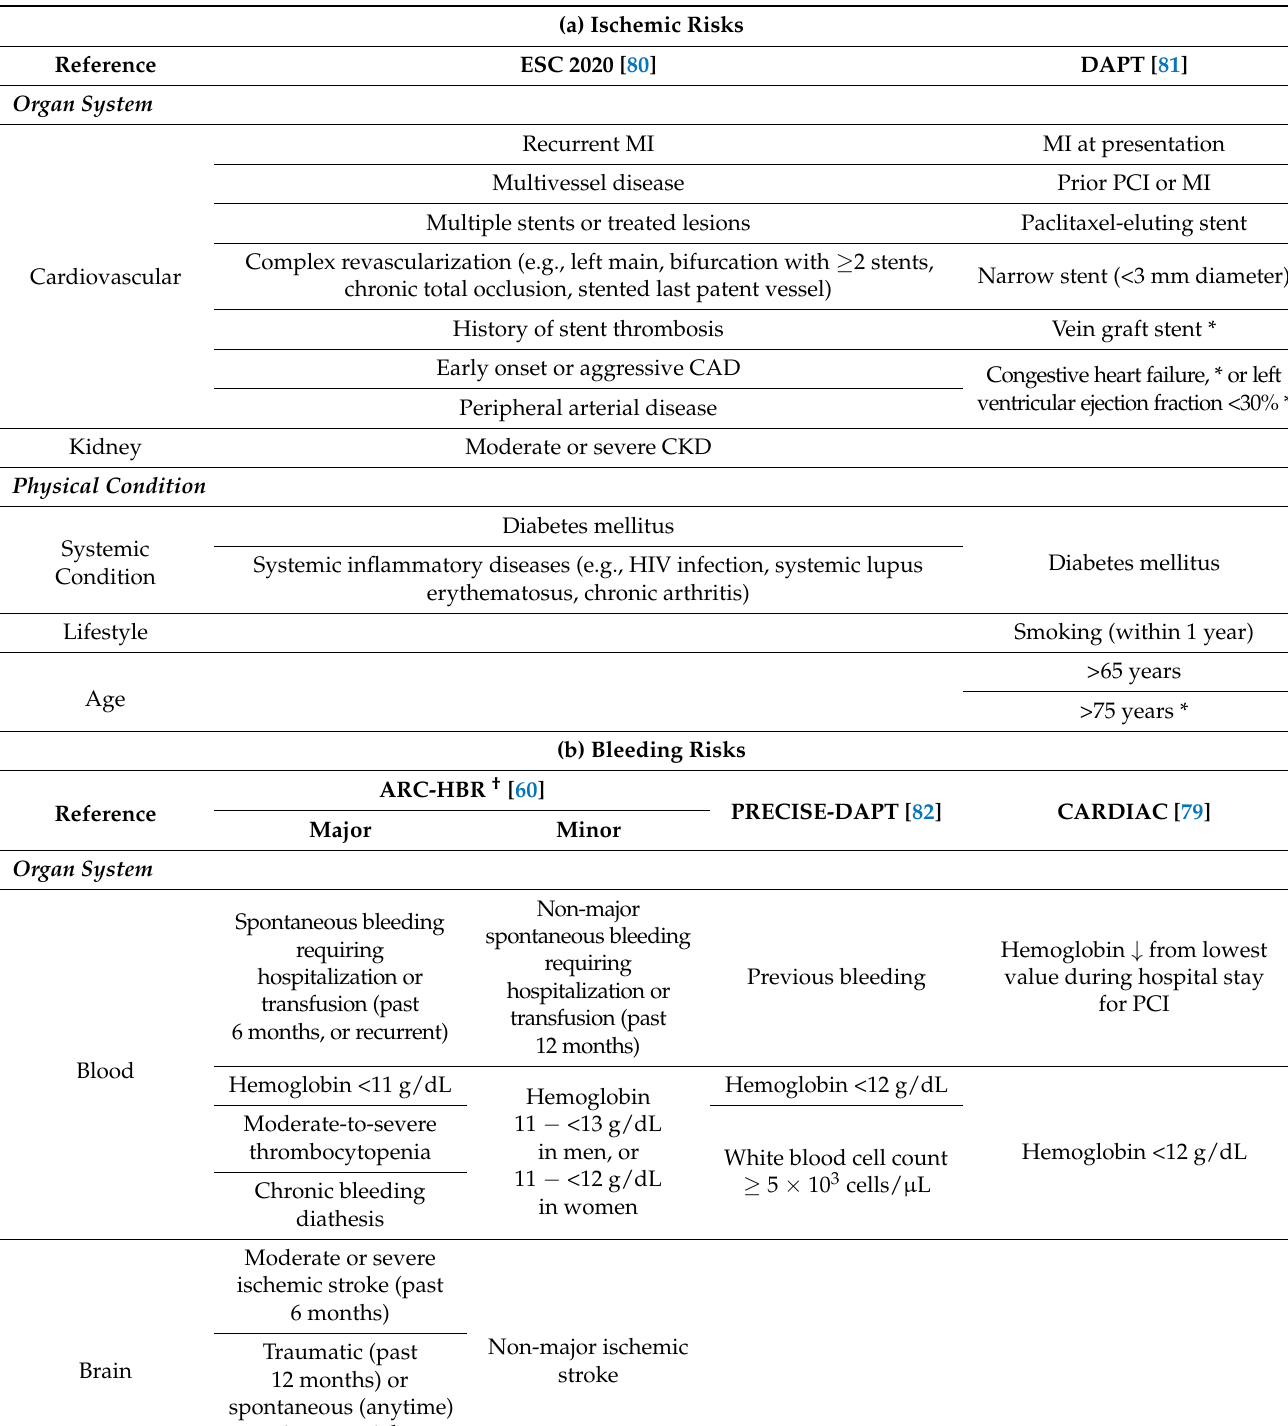
Table 4. Common (a) ischemic and (b) bleeding risk factors for patients with coronary artery disease (CAD) receiving antiplatelet therapy